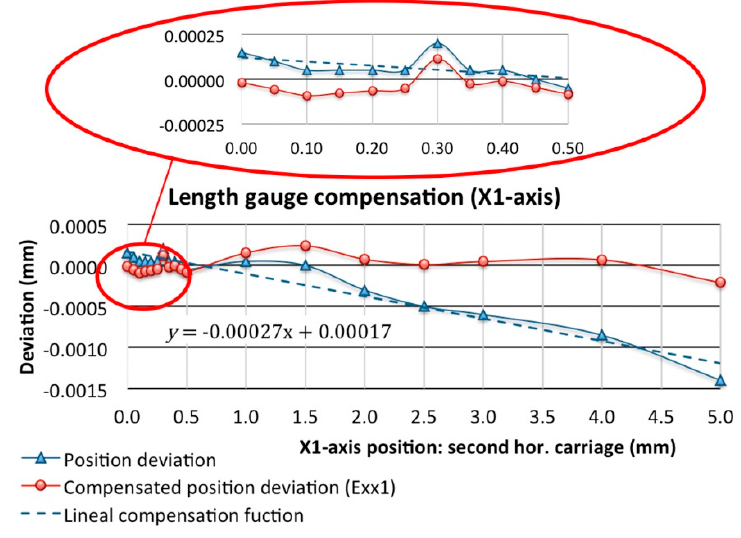
Figure 16. Length gauge compensation (X1-axis).